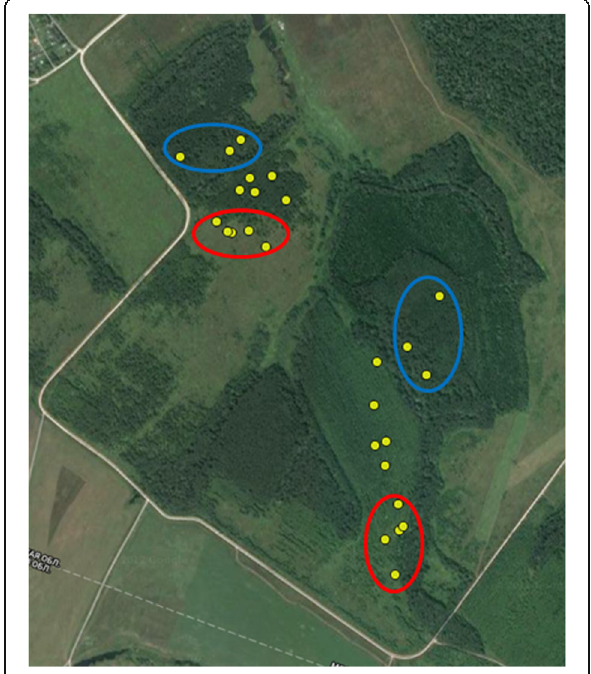
Fig. 3 High-resolution satellite image with sample plots at the local scale (Yandex Maps 2017). Blue ellipses contain plots in patches of mature forests, red ellipses contain plots in burnt abandoned arable lands, and points without ellipses are plots in unburnt abandoned arable